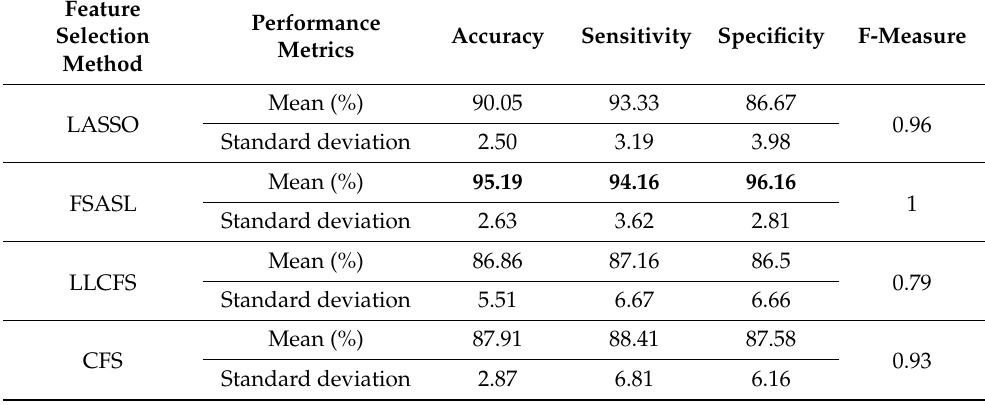
Table 4. Classification performance for MCI against AD using SL-RELM classifier on whole brain network using different feature selection